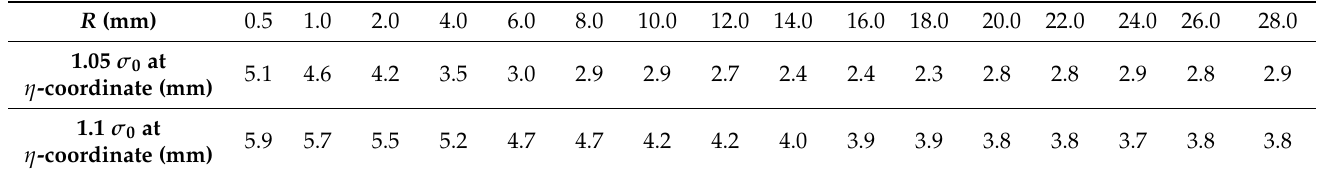
Table 1. In geometry A and a fillet radius R between 0.5 mm and 28.0 mm: η -coordinate at which the maximum principal stress along the path takes the values of 1.05 σ 0 and 1.1 σ 0 .